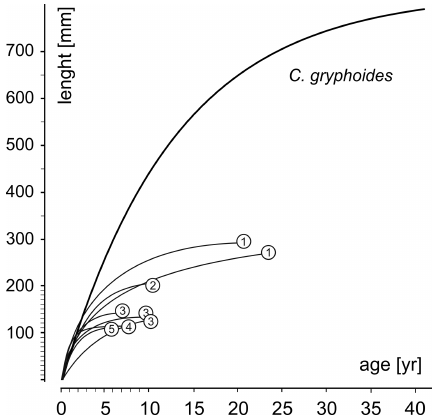
Figure 10. Comparison of von Bertalanffy growth model of Crassostrea gryphoides with selected fossil and extant Cras- sostrea species. 1: C. titan (Conrad, 1853), Miocene, California, USA (Kirby, 2001); 2: C. madrasensis (Preston, 1916), recent, Bangladesh (Nurul Amin et al., 2008); 3: C. virginica (Gmelin, 1791), recent and Pleistocene Virginia, USA (Kirby, 2001; Pow- ell et al., 2011); 4: C. corteziensis (Hertlein, 1951), recent, Mexico (Chávez-Villalba et al., 2005); 5: C. gigas (Thunberg, 1793), recent, Marennes-Oleron, France (Berthome et al.,